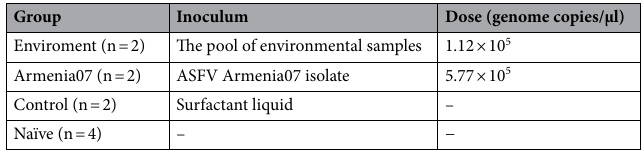
Table 1. Protocol for each group of inoculated and control